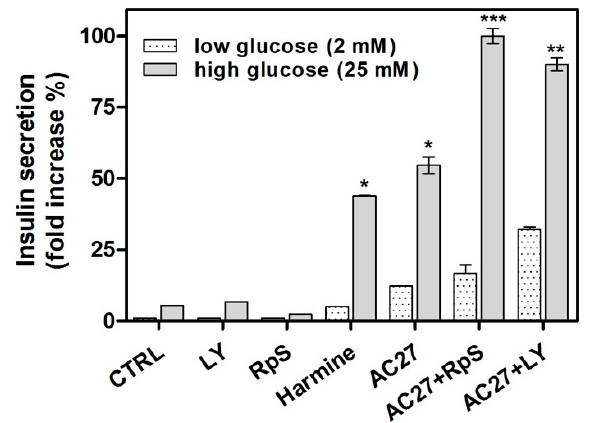
Figure 12. The activity of DYRK1A inhibitors in advanced models–isolated mouse islets. The insulin secretion assay was performed by incubating islets with the selected inhibitors (alone, with RepSox, with LY364947) at basal (2 mM, dotted bars) and high (25 mM, grey bars) glucose concentration. Values are normalized to the total amount of insulin, and insulin secretion is expressed as a fold increase where the basal level is set at 1. Data are presented as the arithmetic mean ± SEM. Data are expressed as mean ± SEM. * p < 0.05, ** p < 0.01, *** p < 0.001; as compared to